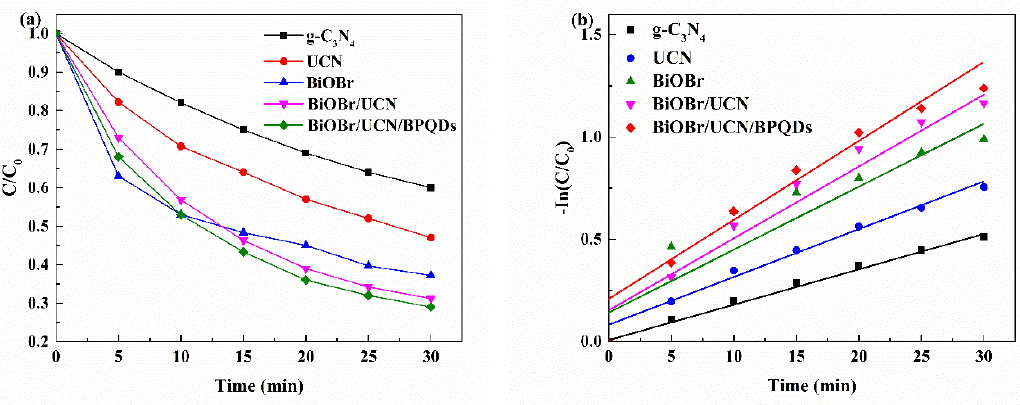
Figure 9. ( a ) Degradation of tetracycline within 30 min, and ( b ) corresponding kinetic equations.